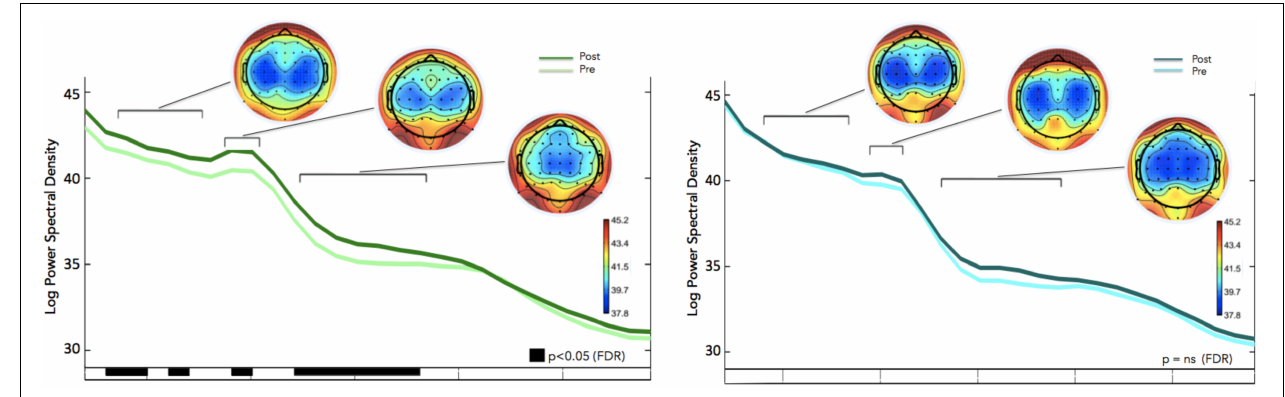
FIGURE 6 | Frequency Spectra for the Neurofeedback group (top, green) and sham group (bottom, blue) showing differences in averaged spectral power between pre (session 1) and post (session 8) for electrode Fz (feedback location). Significant differences in multiple frequency bands were observed for the Feedback group ( p < 0.05, corrected for multiple comparisons; p -values are reflected as black bars above the x-axis). No significant differences were observed in the sham group.